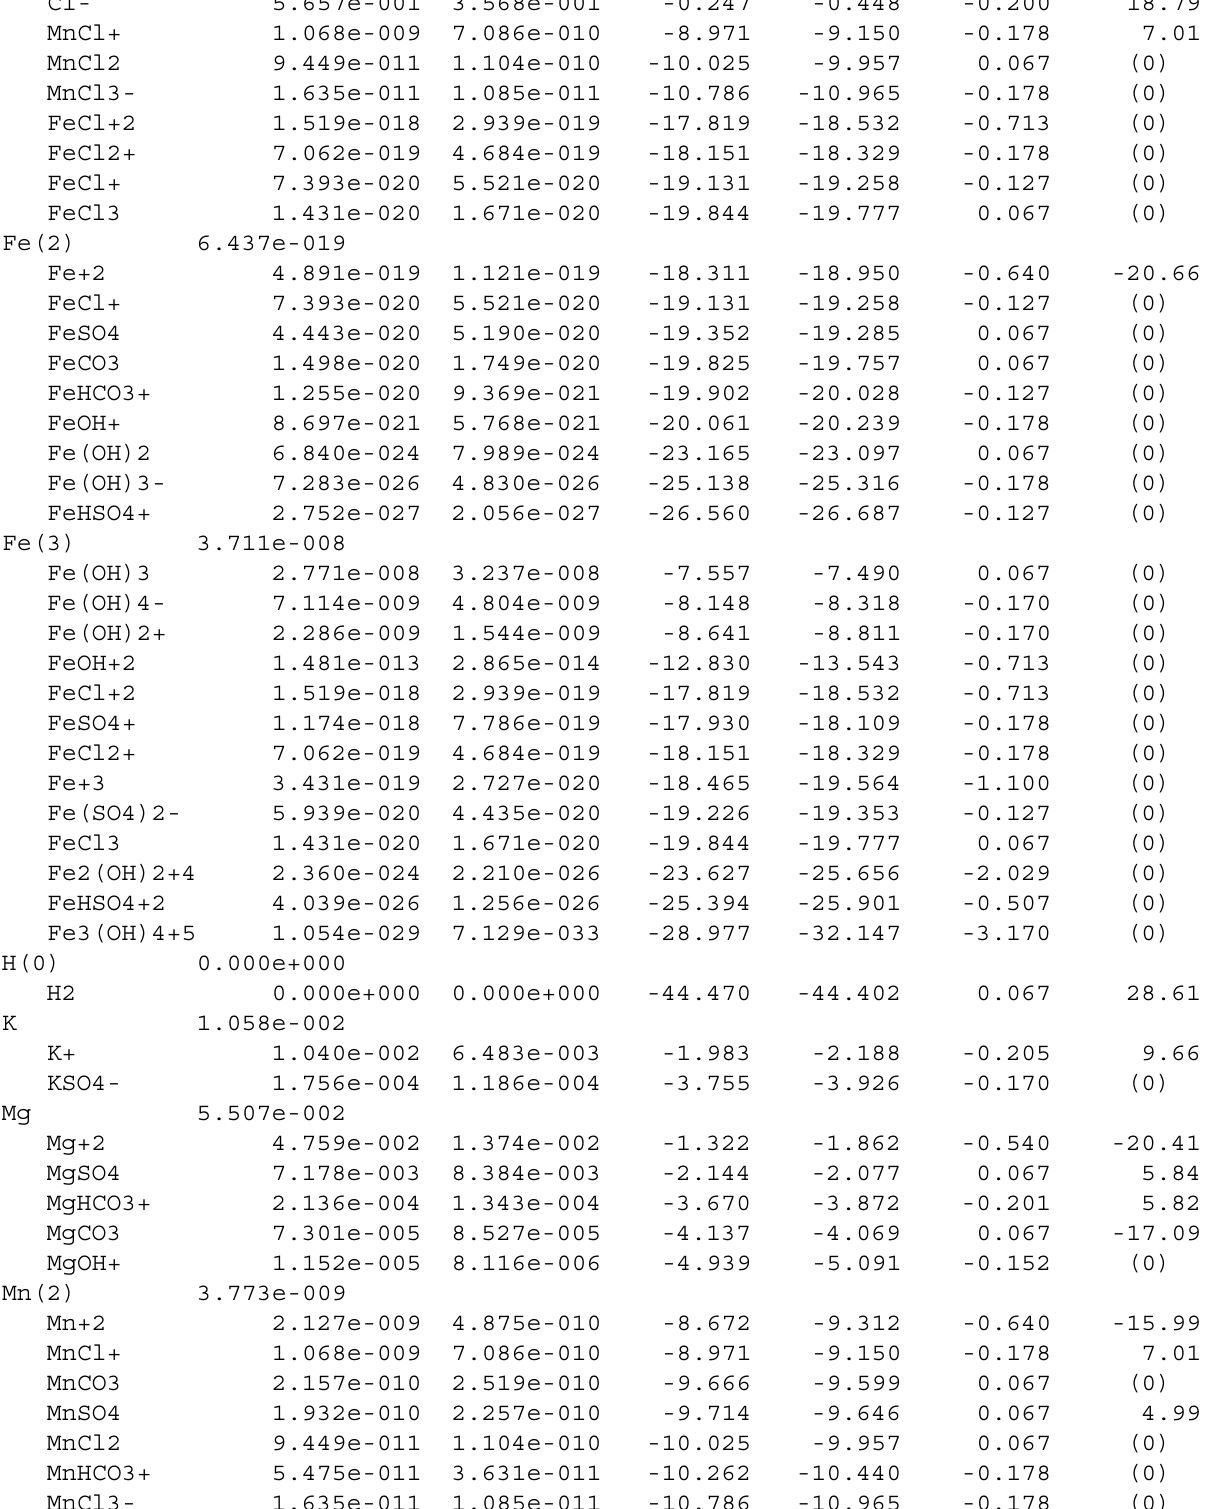
Table 11. Output for example